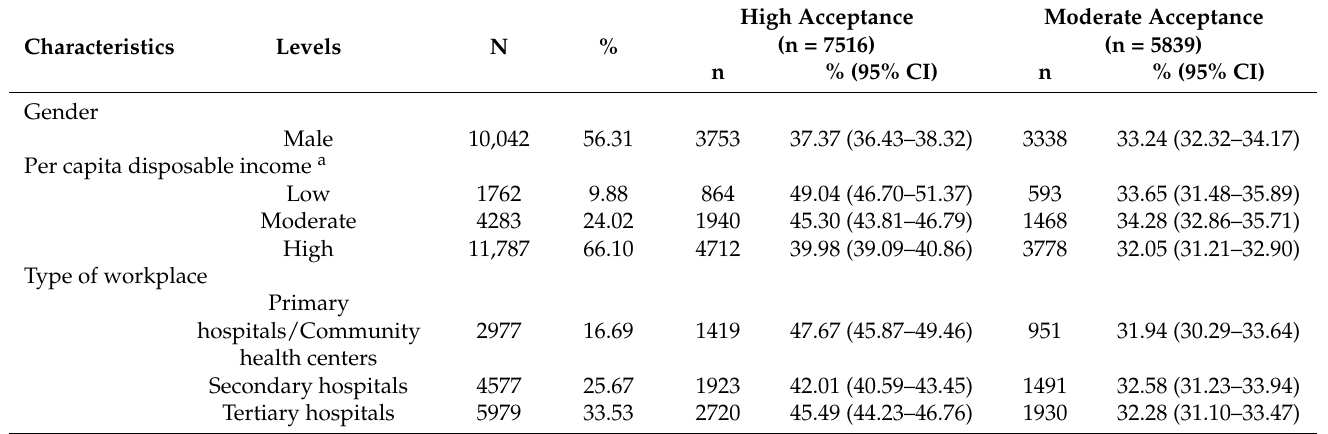
Table 1. Healthcare workers’ characteristics and their attitude toward influenza vaccines (N =